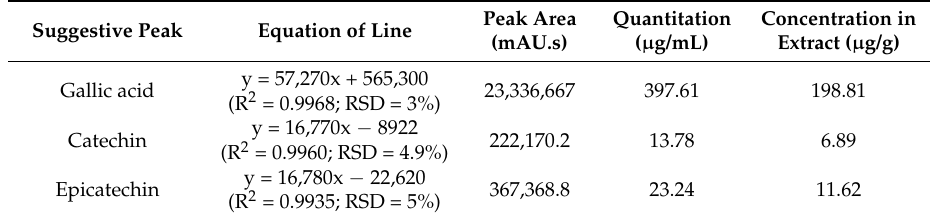
Table 4. Quantitation of gallic acid, catechin and epicatechin in EtOAc phase of extract of stem bark of A.